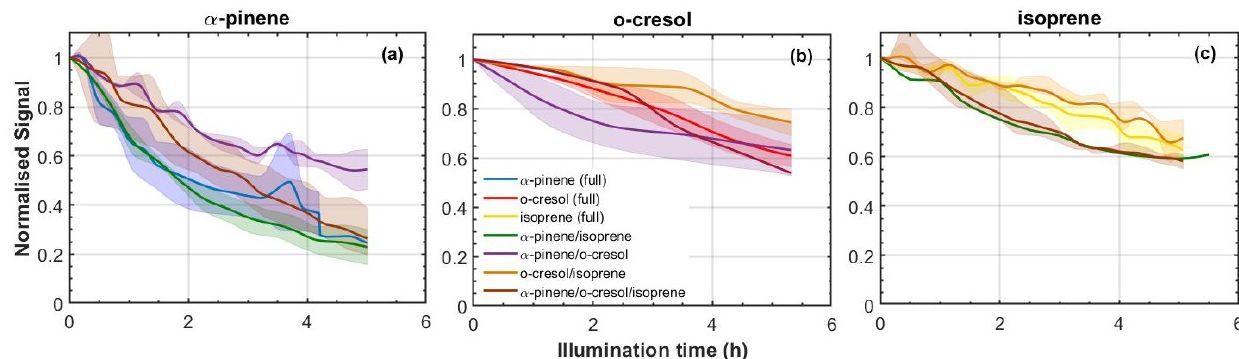
Figure 2. Decay rates of each VOC across all mixtures: (a) α -pinene, (b) o -cresol, and (c) isoprene. All lines (and shaded areas) containing blue correspond to experiments including α -pinene, containing red to those including o -cresol, and yellow to isoprene. For example, purple lines correspond to an α -pinene– o -cresol binary mixture and brown to the ternary mixture. The shaded areas represent the envelope of measurements from all repeat experiments around the solid line